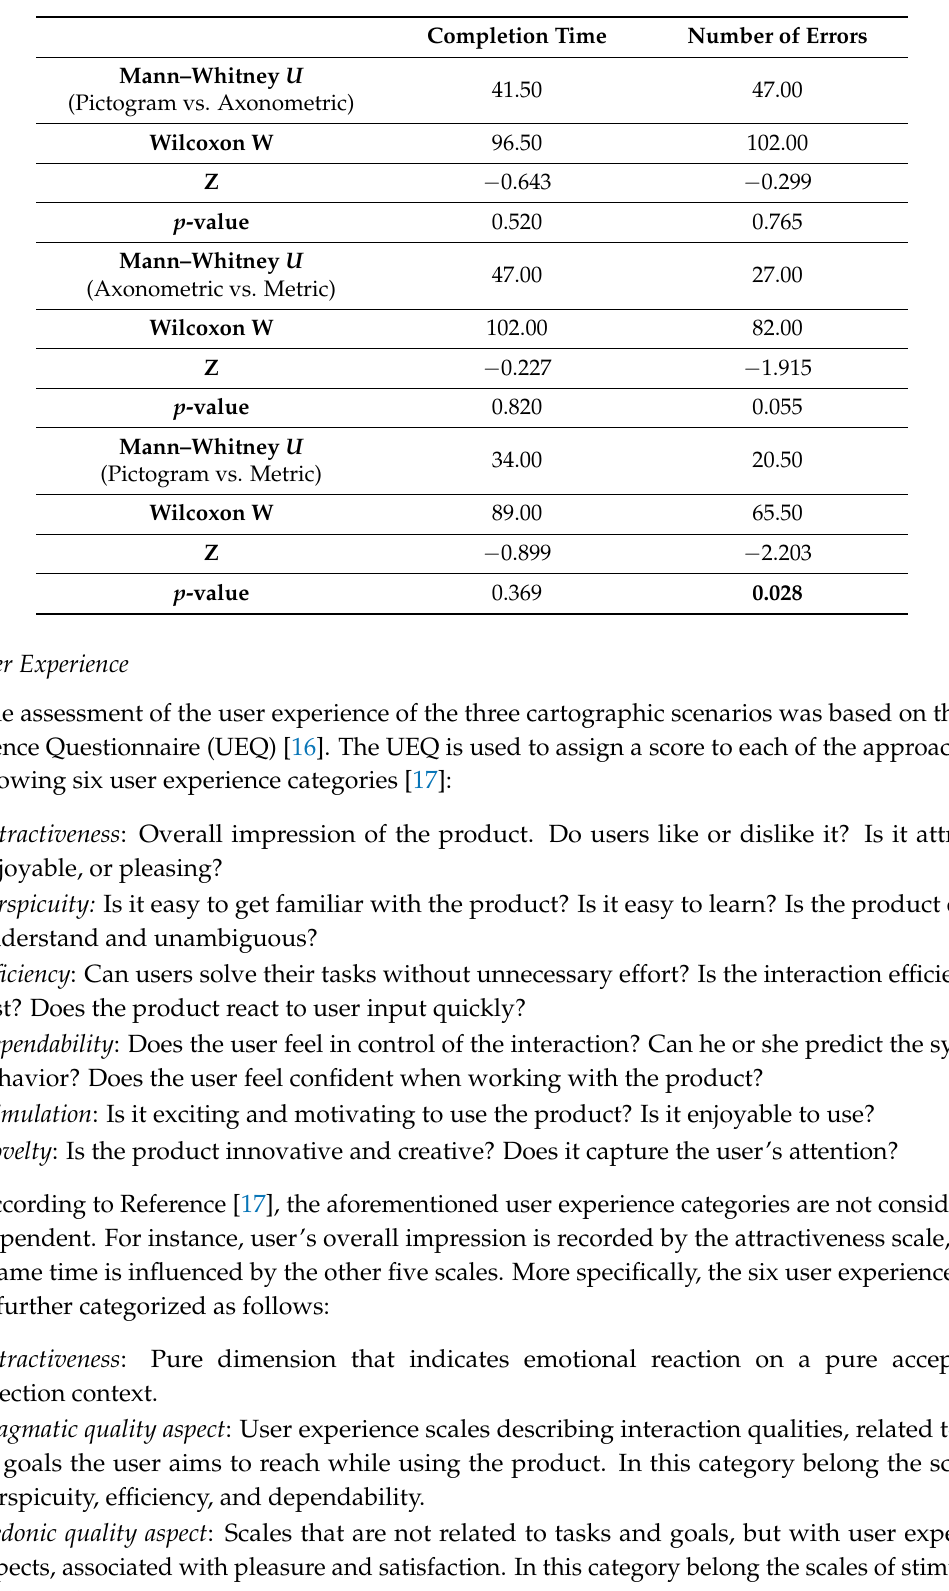
Table 8. Mann–Whitney U test results between all pairs of conditions (pictogram vs. axonometric, pictogram vs. metric, axonometric vs.